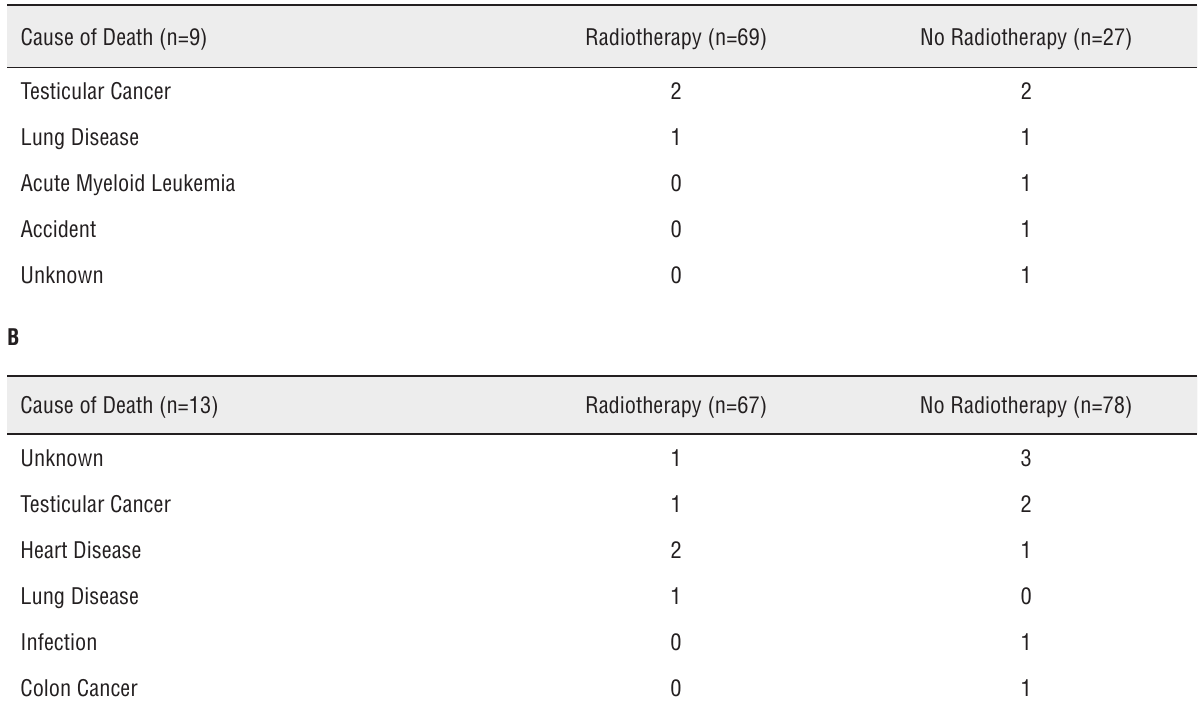
Table 2 – A) Causes of Death in Stage IIA Testicular Seminoma Patients, B) Causes of Death in Stage IIB Testicular Seminoma